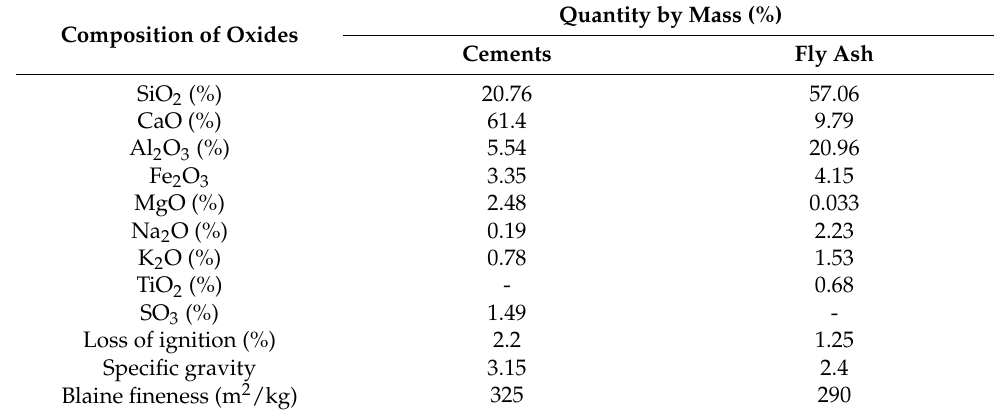
Table 1. Characteristics of binder.